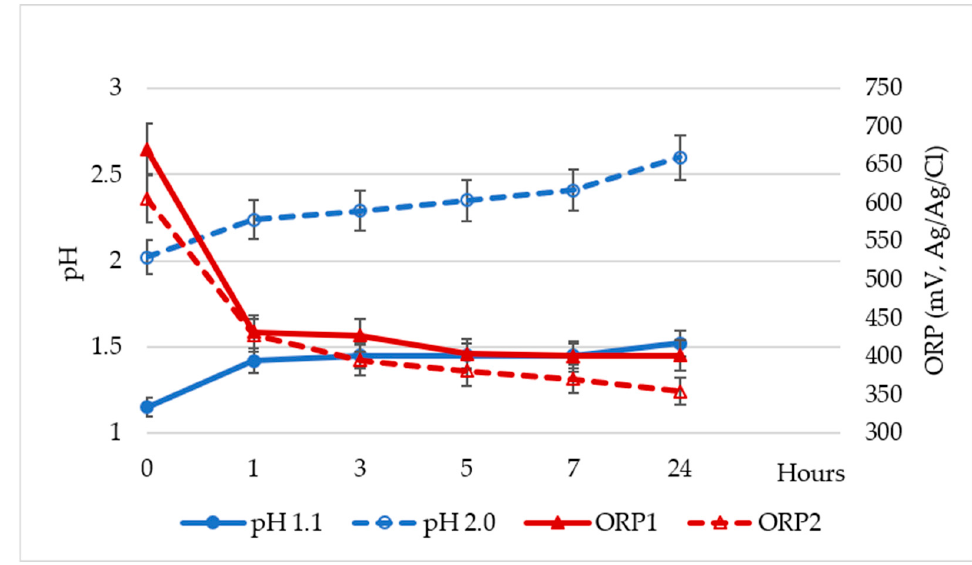
Figure 9. Variation of pH and ORP during bioleaching of PCBs (PD 5%; initial pH 2.0; 20 g/L Fe 3+ ; 40 °C, air 1 lpm; 600 rpm; duration 24 h).